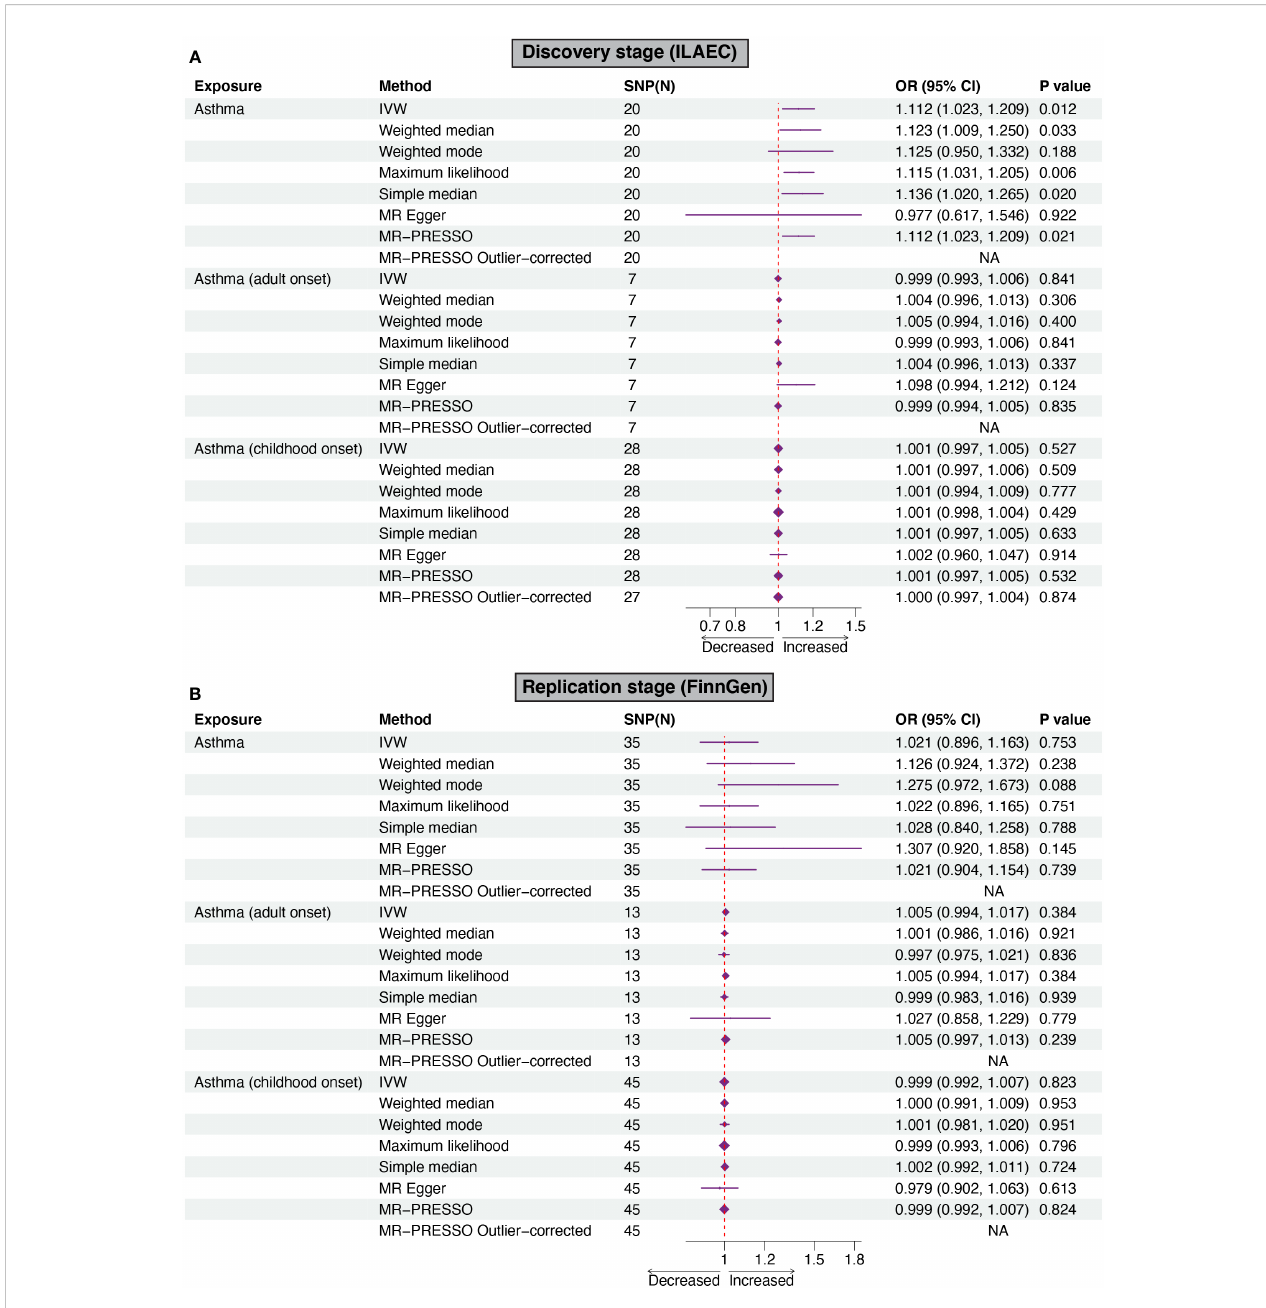
FIGURE 2 Forest plots of Mendelian randomization analyses show the causal effects of asthma on epilepsy. Six different methods, including IVW, weighted mode, weighted median, MR-Egger regression, MR-PRESSO, simple median, and maximum likelihood were used to evaluate the causal effect of asthma on epilepsy. (A, B) showed the causal effect of asthma on epilepsy in the discovery stage and replication stage, respectively. IVW, inverse variance weighed MR-PRESSO, MR-Pleiotropy RESidual Sum, and